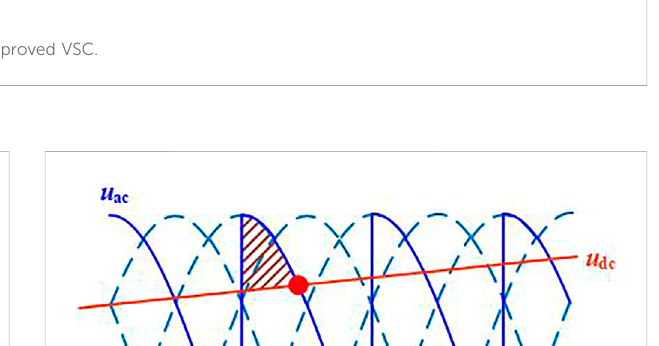
FIGURE 5 Equivalent circuit for the calculation of i S and u dc in each basic control period.